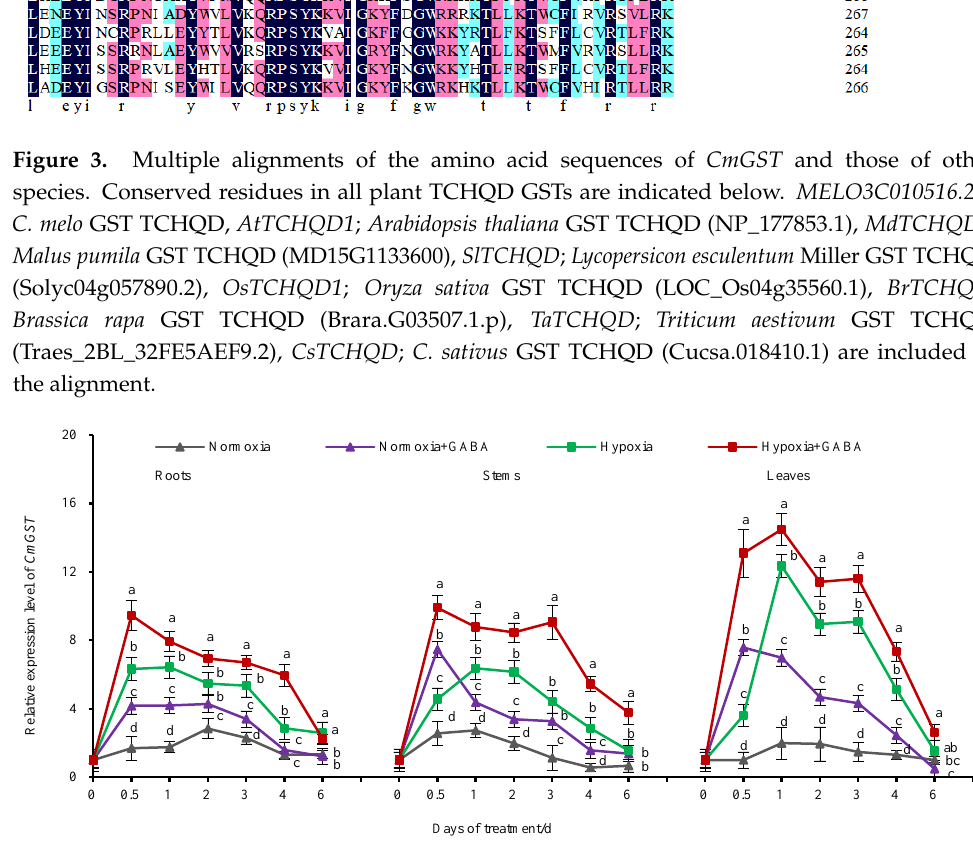
Figure 4. Effects of exogenous GABA on the relative expression of CmGST in the roots, stems, and leaves of melon seedlings under root hypoxic stress for 0–6 d. Different letters a–d indicate significant difference ( p < 0.05).